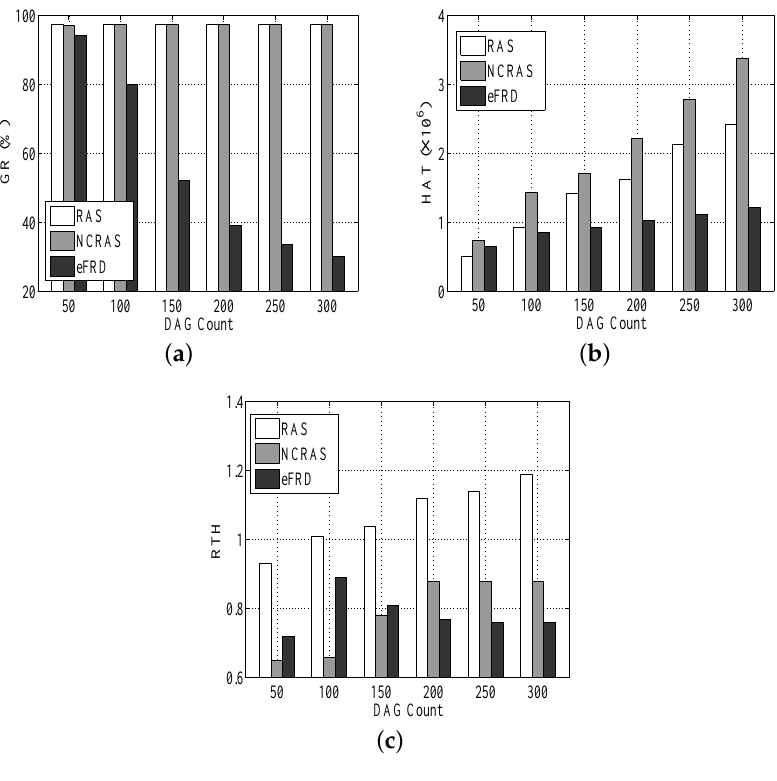
Figure 5. Performance impacts of the DAG count. ( a ) Impact of the DAG count on GR, ( b ) Impact of the DAG count on HAT, ( c ) Impact of the DAG count on